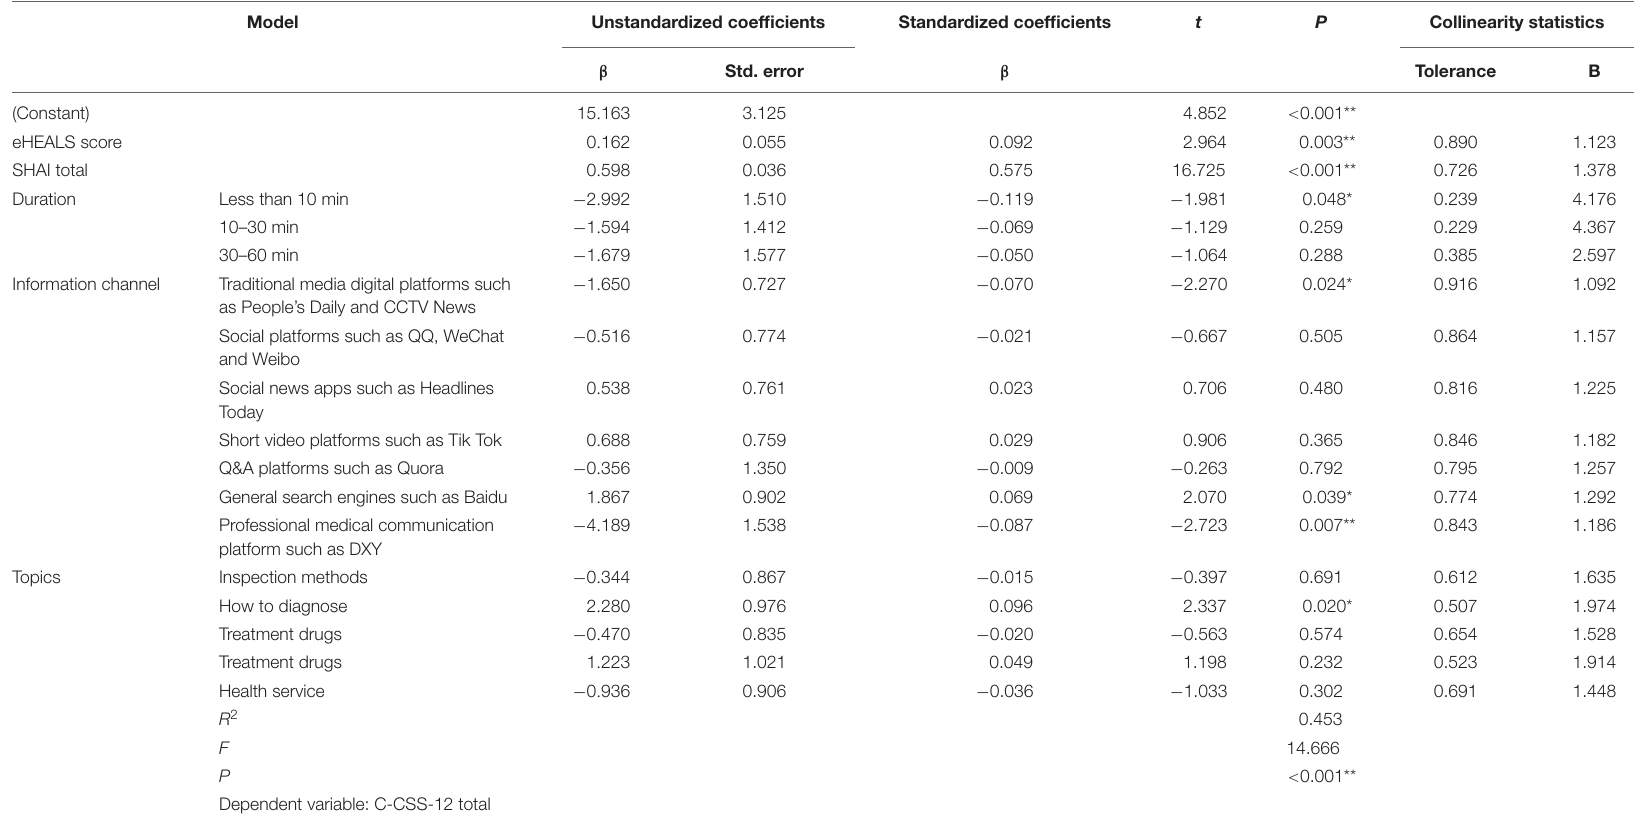
TABLE 6 | The multiple linear regression results on associated factors with